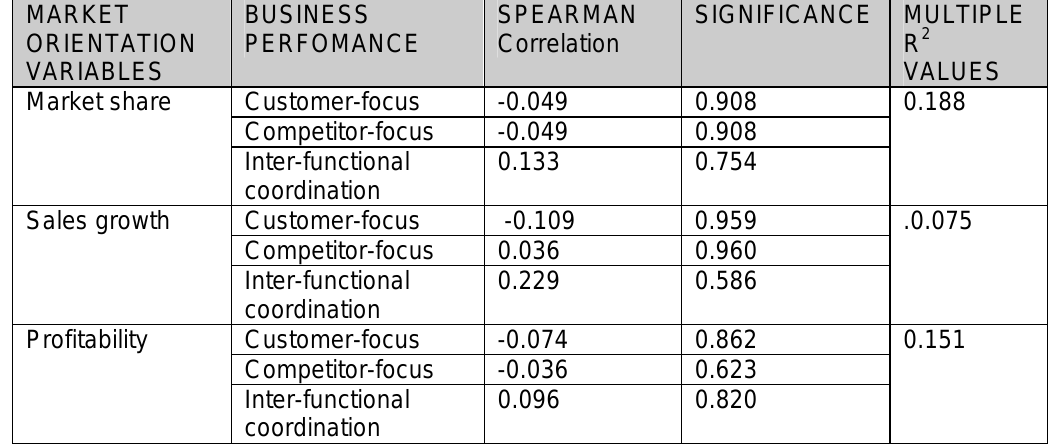
Table 2: Multiple regressions of market orientation and Business